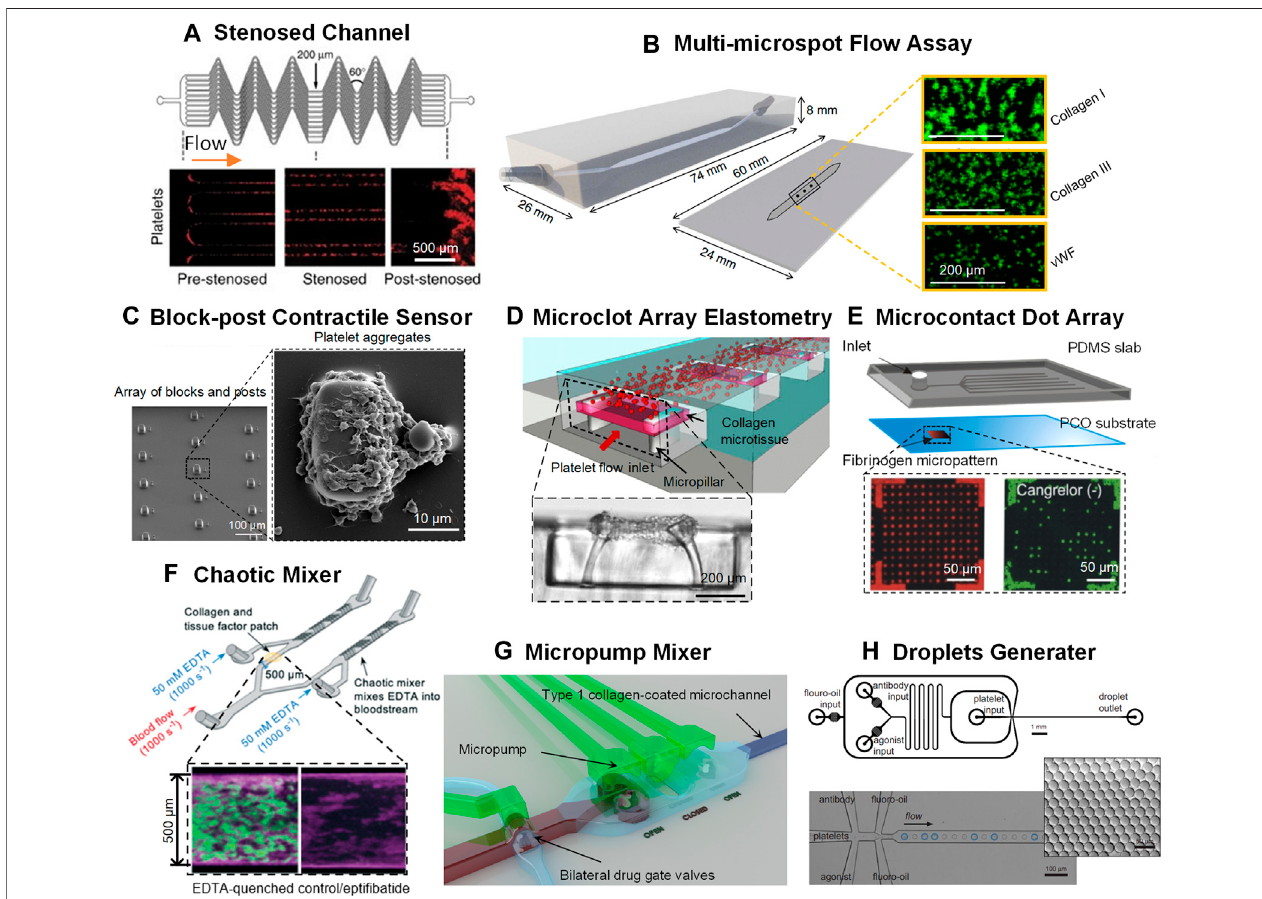
FIGURE1| Novelmicro fl uidicplatformsaspoint-of-caretestofplateletfunctionandanti-plateletdrugscreening. (A) Anetworkofparallelstenosedmicrochannels which contain multiple regions of pre-stenosis, stenosis and post-stenosis from Jain et al. (2016a). (B) A multi-microspot micro fl uidic fl ow system from de Witt et al. (2014); Zoom-in: thrombi formed on the collagen/VWF microspot surfaces. Scale bar (cid:1) 200 μ m. (C) Block-post contractile sensor from Ting et al. (2013), Ting et al. (2019); Left: SEM micrograph of an array of blocks and posts. Scale bar (cid:1) 100 μ m; Right: SEM micrograph of a platelet aggregate formed after 45 s at 8,000 s − 1 . Scale bar (cid:1) 10 μ m. (D) Amicroclot arrayelastometrysystemfrom Chen Zet al. (2019);Top: An arrayofexposed collagenmicrotissuescapturing the fl owingplateletsto formindividualmicroclots;Bottom:Sideviewofamicrotissueafterplatelet-mediatedcontraction.Scalebar (cid:1) 200 μ m. (E) ThemicrocontactprinteddotarraysfromJose et al. (2016); Top: Schematic of the micro fl uidic assembly; Bottom: Fluorescence images of 6- μ m Cy-3-labeled fi brinogen-dot arrays (red dots) and of FITC-labeled platelets(green dots) adheringtothe fi brinogen dot arrays.Scale bar (cid:1) 50 μ m. (F) A chaotic mixerfrom Berry et al.(2021); Top: Schematic ofthechaoticmixer;Bottom: Confocal images of platelets (and leukocytes) and fi brin in EDTA-quenched channel (left) and the epti fi batide channel (right). (G) An active micropump mixer with micropump valve chambers and pneumatic actuation chambers from Szydzik et al. (2019). (H) Droplet micro fl uidics from Jongen et al. (2020); Top: Schematic of the dropletgeneratordesign.Scalebar (cid:1) 1 mm.Bottom:Monodispersedropletsencapsulatingplatelets.Scalebar (cid:1) 100 μ m.Zoom-in: dropletmonodispersityisindicated by hexagonal packaging. Scale bar (cid:1) 50 μ m.